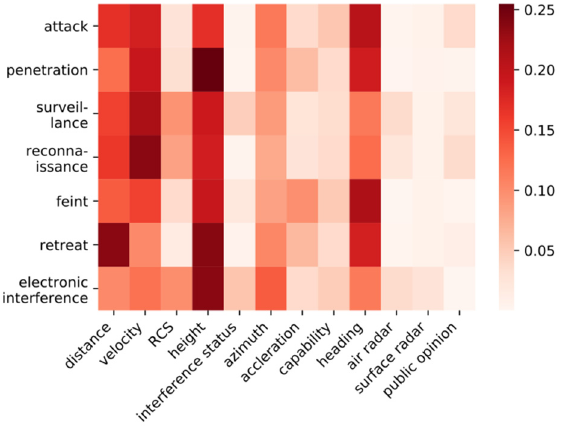
Figure 14. Attention mechanism assigns weight to characteristics.